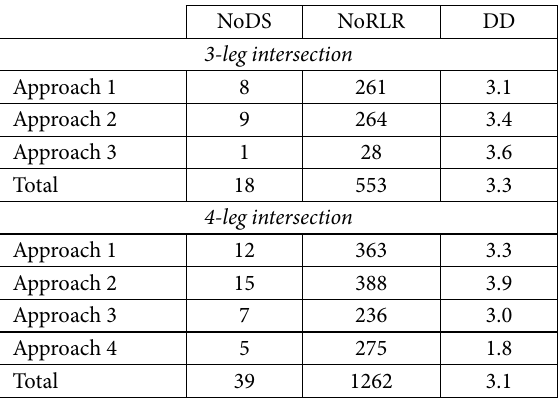
Table 11. DD for the intersection overall and for the approaches